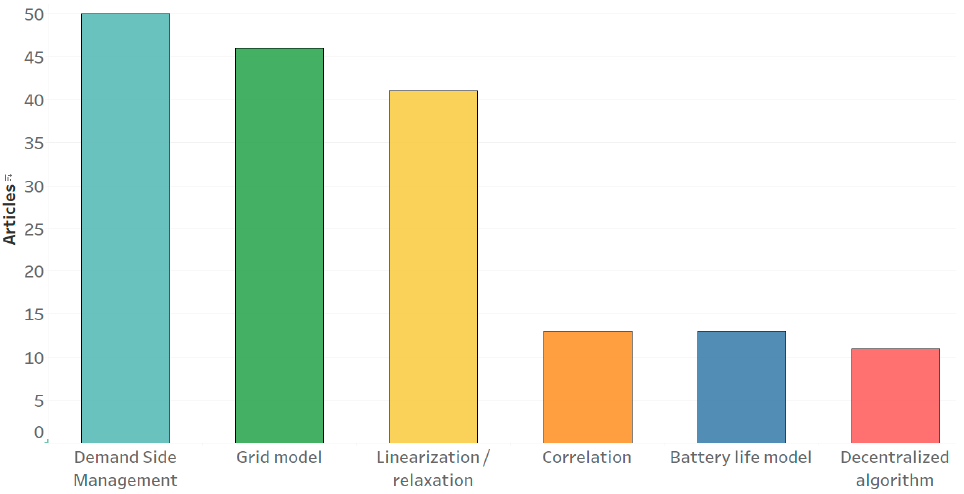
Figure 11. Number of articles that consider one of the additional features explained in the current section.